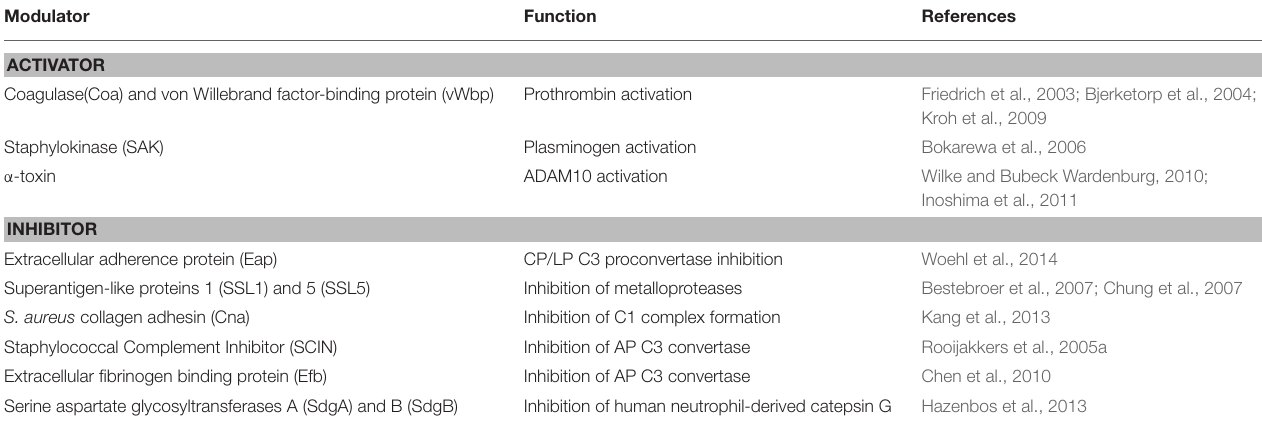
TABLE 2 | The main S. aureus modulators of host